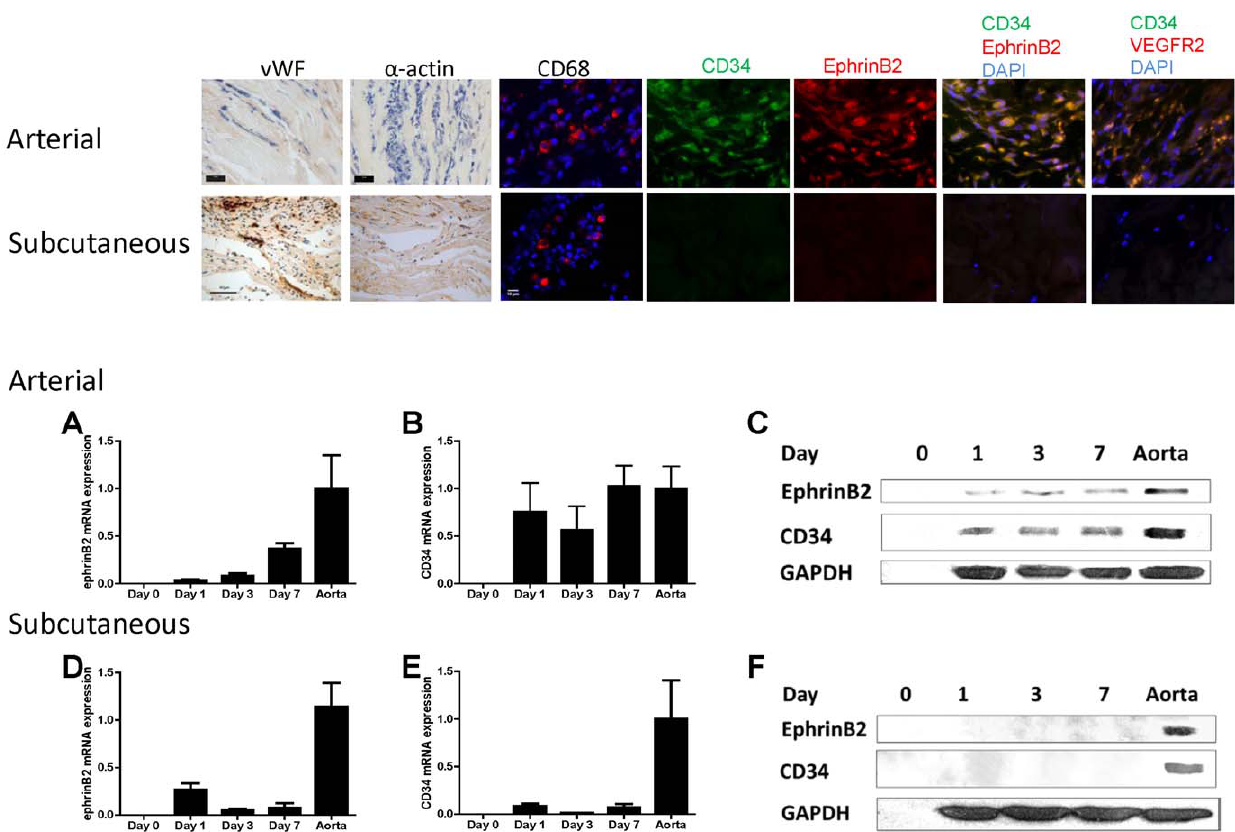
Figure 3. Cells infiltrating into arterial, but not subcutaneous, patches have markers for either macrophages or arterial progenitor cells. Scale bar, 10 microns, except 40 microns for subcutaneous histology. n=3; representative pictures are shown. Immunofluorescence shows CD34 and Ephrin-B2-positive cells colocalize in the middle of the bovine arterial patch, day 7. Photomicrographs of immunofluorescence: blue color, DAPI; green color, CD34; red color, Ephrin-B2; merge, green + red. n=3; representative pictures are shown. Scale bar, 10 microns. Similarly, merge of CD34 and VEGFR2 is shown. Bar graphs show increased expression of Ephrin-B2 and CD34 mRNA and protein in arterial, but not subcutaneous, patches. n=4 2 5. Panels A, B, D, and E, mRNA; Panels C and F, protein.